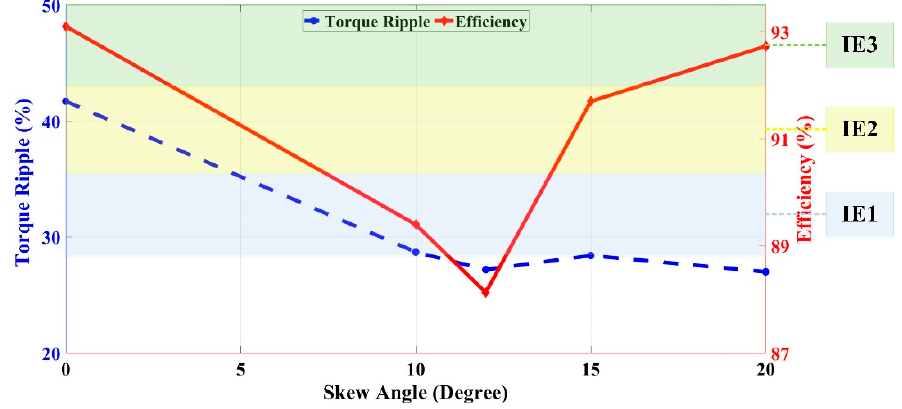
Figure 7. Efficiency and torque results of AFIM with 30 slots.